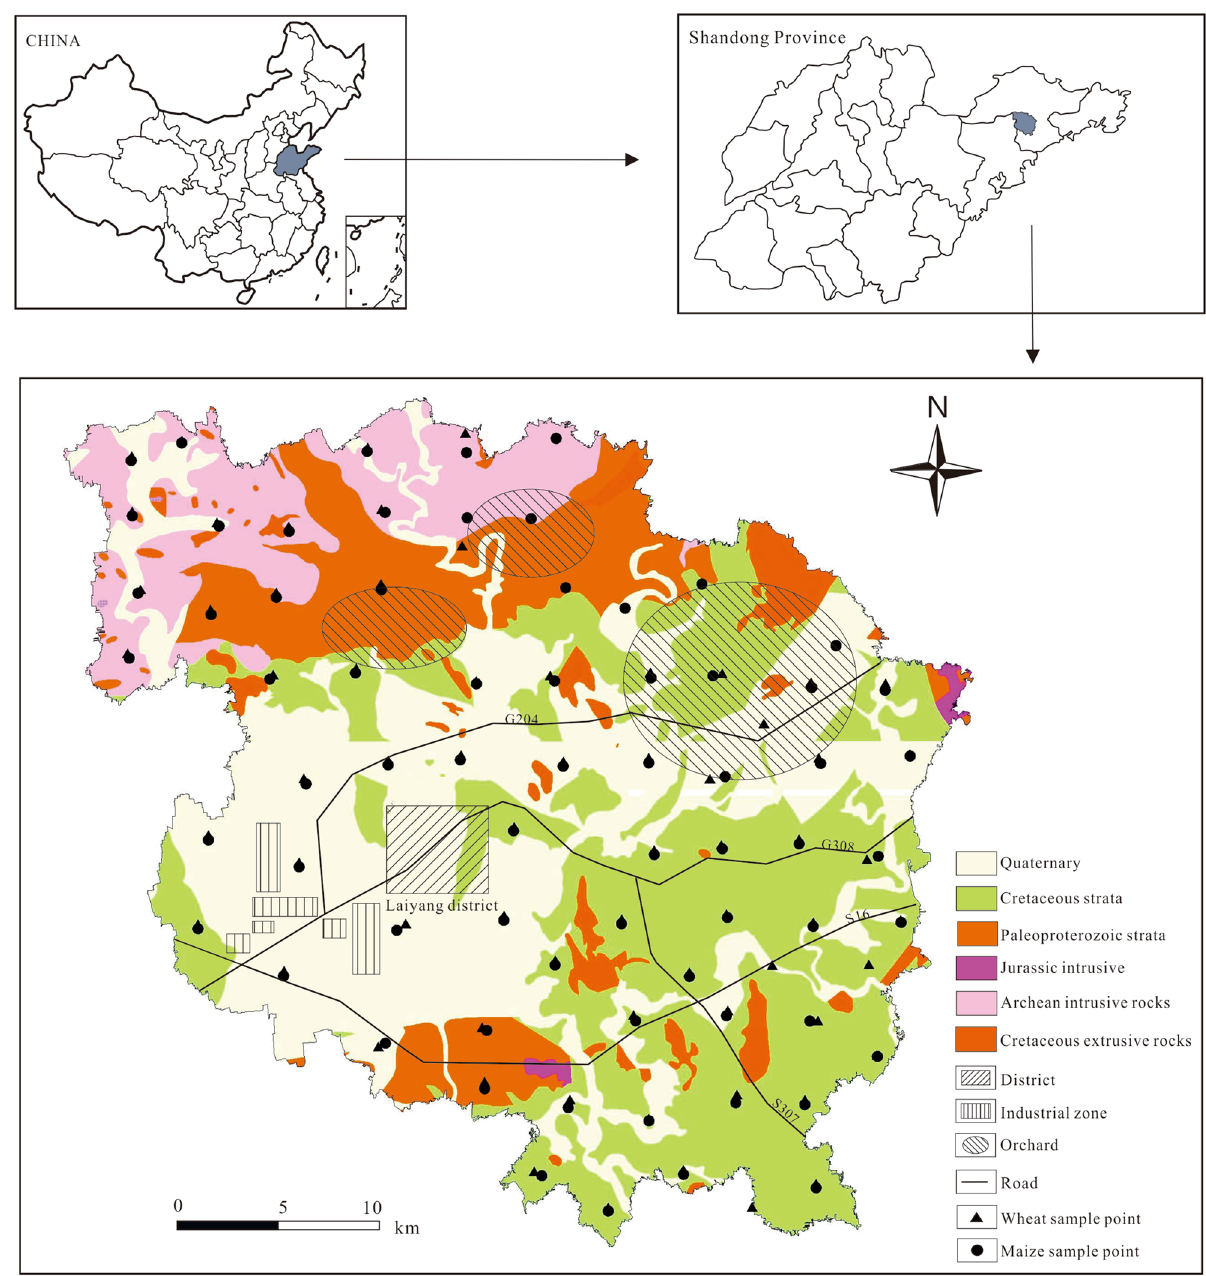
Figure 1. Sampling sites for the present